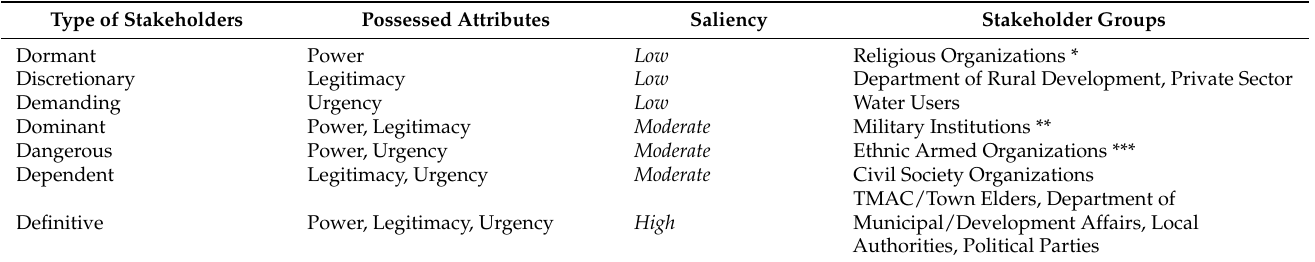
Table 2. Classification of public water supply stakeholders in Rakhine State by using Stakeholder Salience